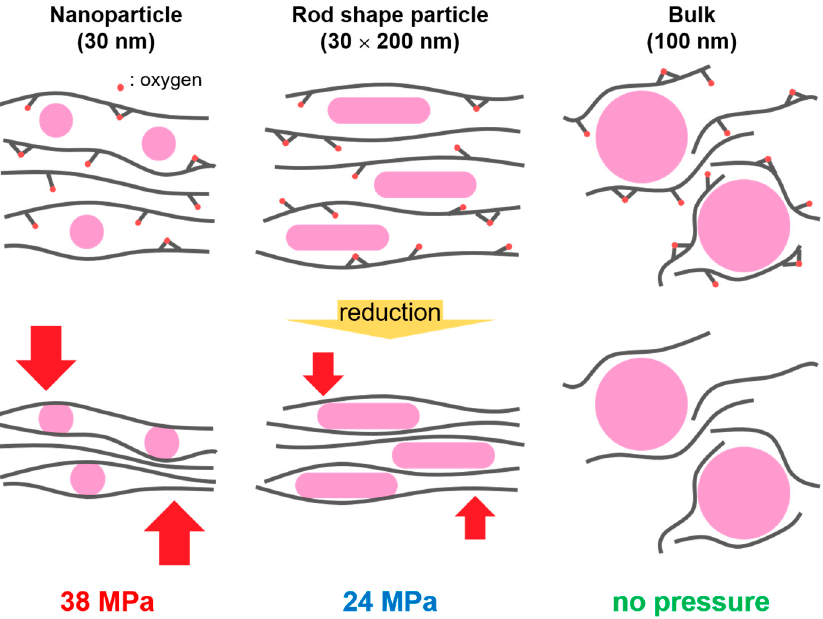
Figure 5. Schematic illustration of the pressure effects with incorporated particle size and shape dependency in the GO/rGO layers.